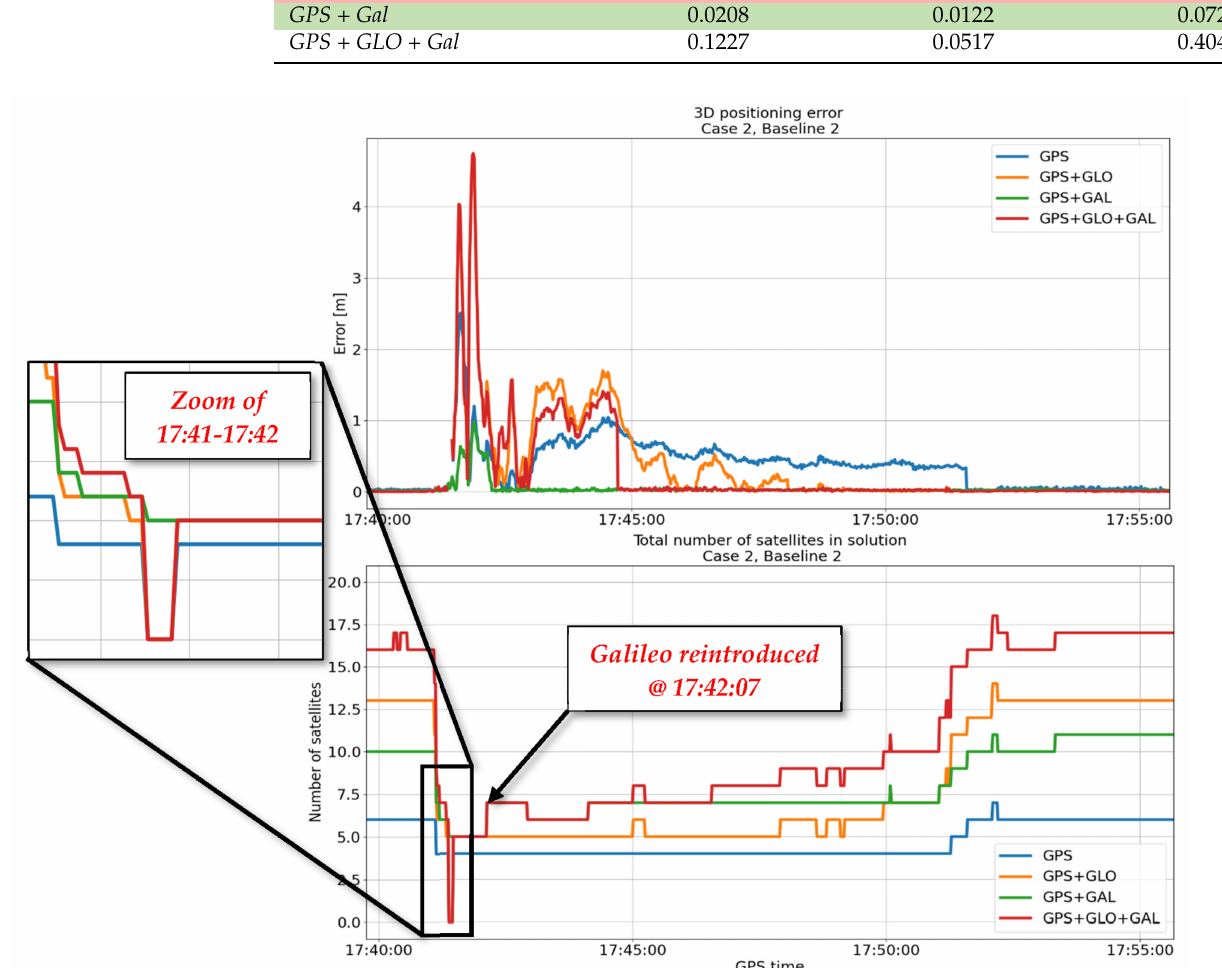
Figure 11. Solution 3D error ( top ) and number of satellites in the solution ( bottom ) for various L1 + L2 PPK solutions to Case 2, baseline 2 (12.1 km). 17:42:07: Galileo is reintroduced to the